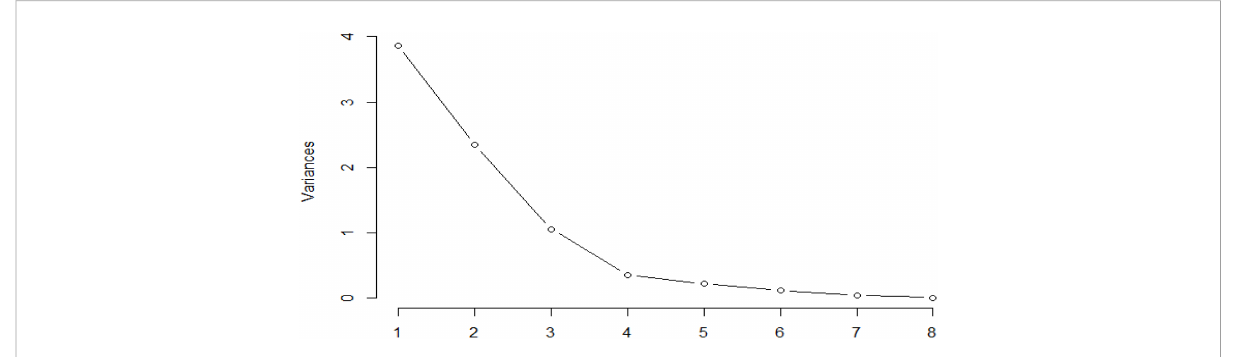
FIGURE 9 Screen plot represents decreasing pattern of cumulative contribution of variation for eight principal